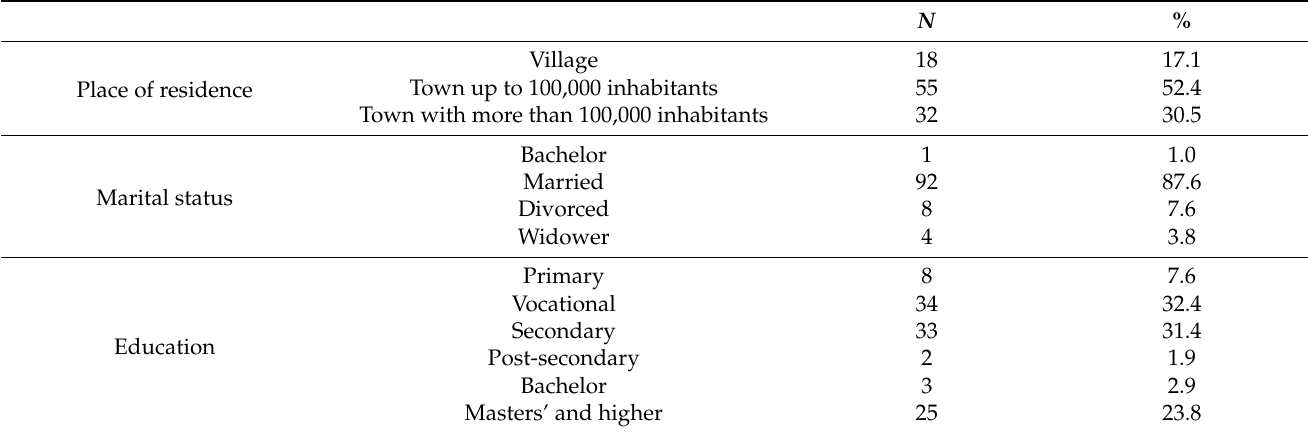
Table 2. Demographic data on marital, educational, and residential status of